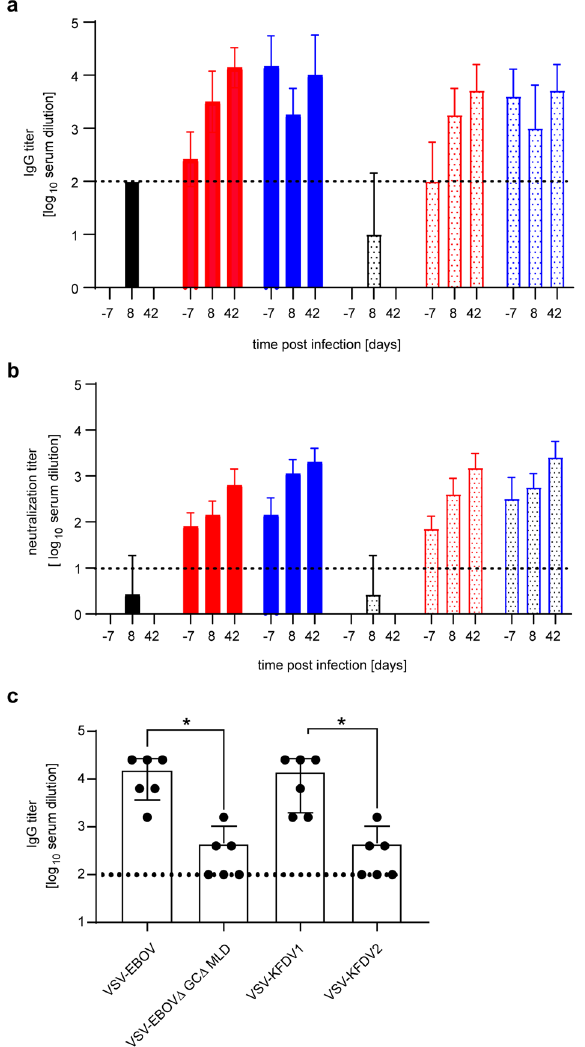
Fig. 5 Humoral immune responses to VSV vector immunization and KFDV challenge in mice. a KFDV-prM-E-speci fi c IgG titers. Total IgG-speci fi c antibodies to KFDV-prM-E were determined by ELISA on serum samples collected from animals immunized prime-only and prime-boost with VSV-KFDV1 (solid bars red and blue, respectively), VSV-KFDV2 (dotted bars red and blue, respectively), VSV-EBOV (solid bar black), and VSV-EBOV EBOV Δ GC Δ MLD (dotted bar black). Samples were collected prior to challenge on day -7 ( n = 12) and following KFDV challenge on 8 dpi ( n = 4) and 42 dpi ( n = 8 for 100% survival and n = 7 for 87.5 % survival). b KFDV-speci fi c neutralization titers. The same serum samples were tested for their neutralizing activity. The highest titer that completely neutralized 100 TCID 50 of KFDV are shown. c EBOV GP-speci fi c IgG titers. Total IgG titers speci fi c to EBOV GP were determined by ELISA on serum samples collected prior to challenge on day − 7 ( n = 6) of mice immunized prime-only with VSV-EBOV, VSV-EBOV Δ GC Δ MLD, VSV-KFDV1, and VSV-KFDV2. The cut-off for seropositivity is indicated by a horizontal dotted line. The value was set at 3 standard deviations above the mean absorbance of pre-immune serum at a dilution of 1:100. Statistical signi fi cance was analyzed using the unpaired T tests in Prism 7 (GraphPad)and results are indicated as * p < 0.05. sequence and the JEV signal peptide sequence 27 were incorporated to ensure transcription initiation and translocation into the endoplasmic reticulum. These sequences were cloned into the VSV genome between the fi rst and second gene of the VSV-EBOV 42 or VSV-EBOV Δ GC Δ MLD plasmids 37 using PacI and AscI restriction enzyme sites (NEB, Ipswich,